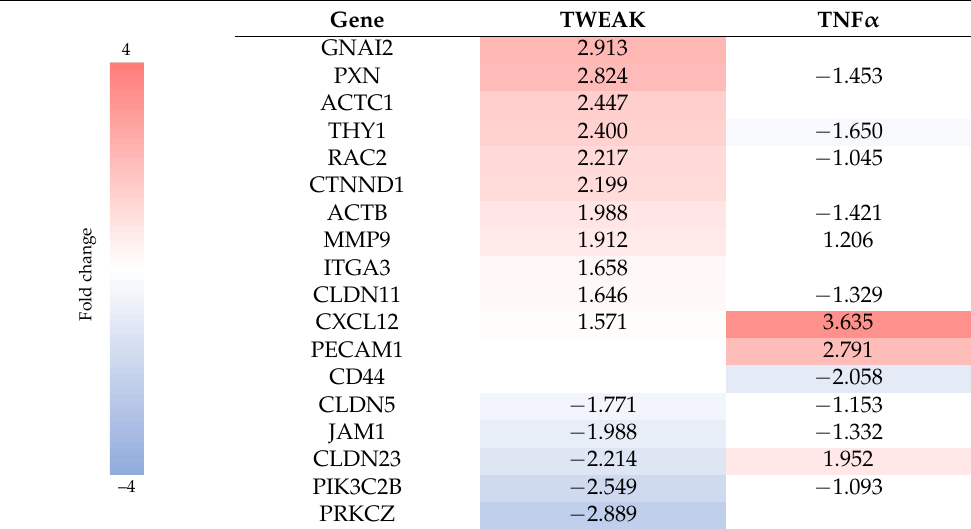
Table 1. Differential expression of IPA-identified genes belonging to leukocyte extravasation signaling in hCMEC/D3 cells after 24 h of TWEAK or TNF α treatment. Red: upregulated genes (FC > 1.5), blue: downregulated genes (FC < − 1.5). FCs with values between − 1 and 1 were not included in IPA-run analysis.